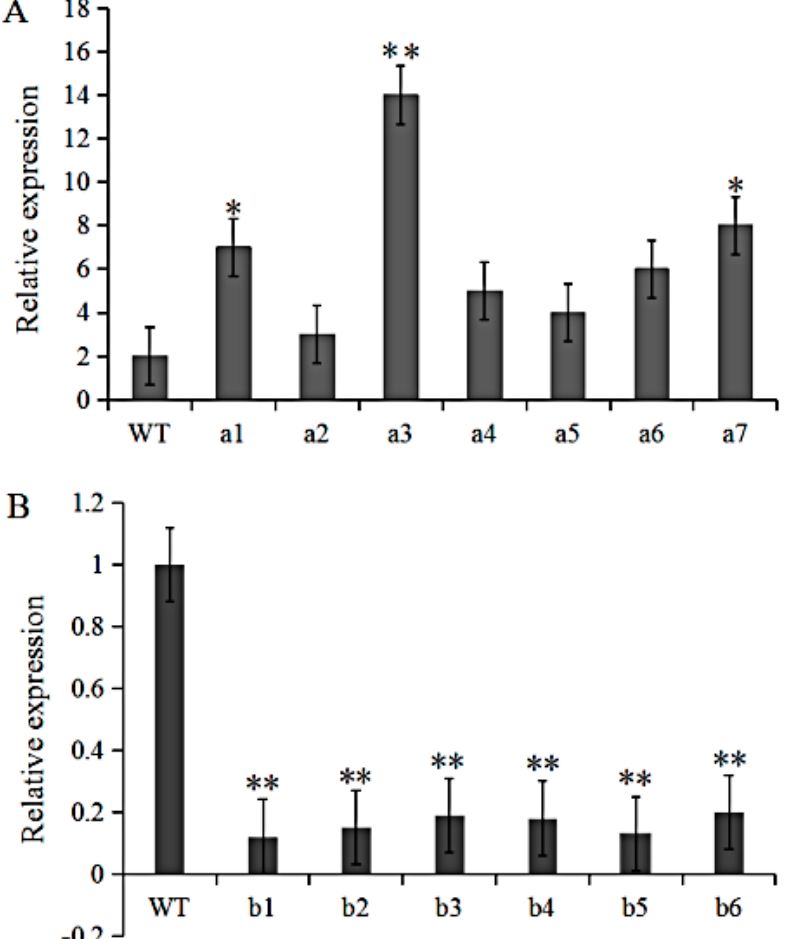
Figure 3. Identification of GmRIQ2 - like- overexpression (OE) and -knock-out (KO) transgenic soybean seedlings. ( A ) Expression patterns of the T 0 generation of GmRIQ2 - like- OE transgenic soybean seedlings (a1–a7). ( B ) Expression patterns of the T 0 generation of GmRIQ2 - like- KO transgenic soybean seedlings (b1–b6). Relative transcript levels were determined by qRT-PCR using the 2 − ∆∆ Ct method; the actin4 gene was used as an internal control. Data are presented as the average of three independent biological experiments ± SE. Asterisks indicate significant differences (* p < 0.05; ** p < 0.01) compared to the control.